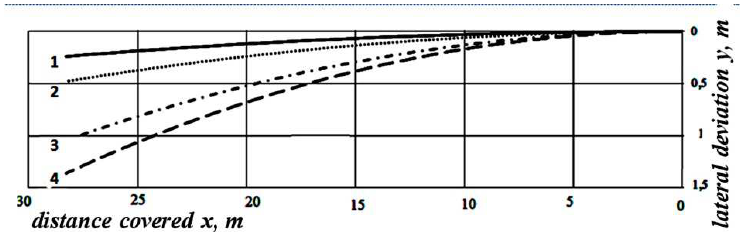
Figure 5. Movement trajectories of the plowing unit: 1 - translational slip, 2 - slip caused by the displaced traction resistance of the plow, 3 - slip caused by different ground contact conditions; 4 - total